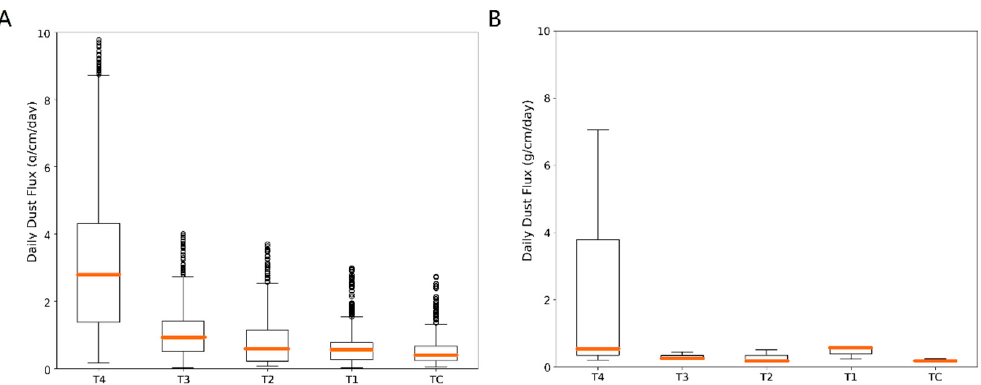
Figure 9. The box plot of daily dust flux (g/cm/day) was computed by using the WEMO model on the upwind area of Treatment 4-Treatment Control (T4-TC, 100% grass removal-0% grass removal). The input of WEMO is from the drone-based estimate (500 transect lines, ( A ) and field measurement (three transect lines, ( B ). The yellow mark represents the median value of dust flux.